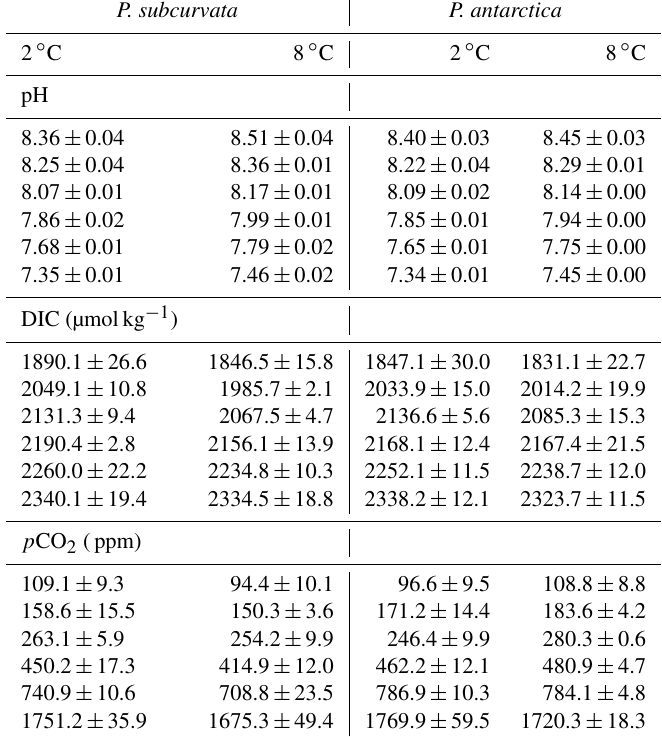
Table 1. The measured pH and dissolved inorganic carbon (DIC) as well as calculated p CO 2 of P. subcurvata and P. antarctica at 2 and 8 ◦ C in each treatment. Values represent the means and errors are the standard deviations of triplicate bottles. P. subcurvata